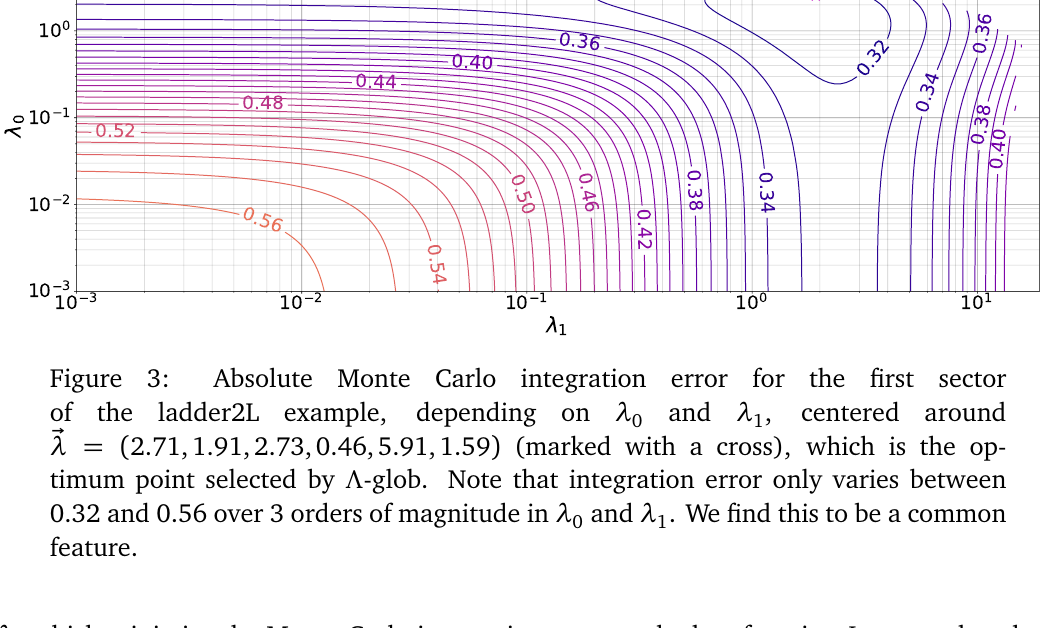
and λ , centered around 0 1 and λ . We find this to be a common 0 1